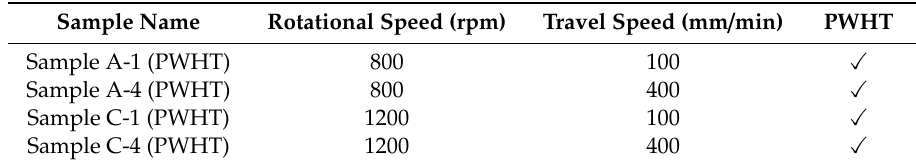
Table 3. Sample name and welding parameters of samples with the post-weld heat treatment (PWHT)